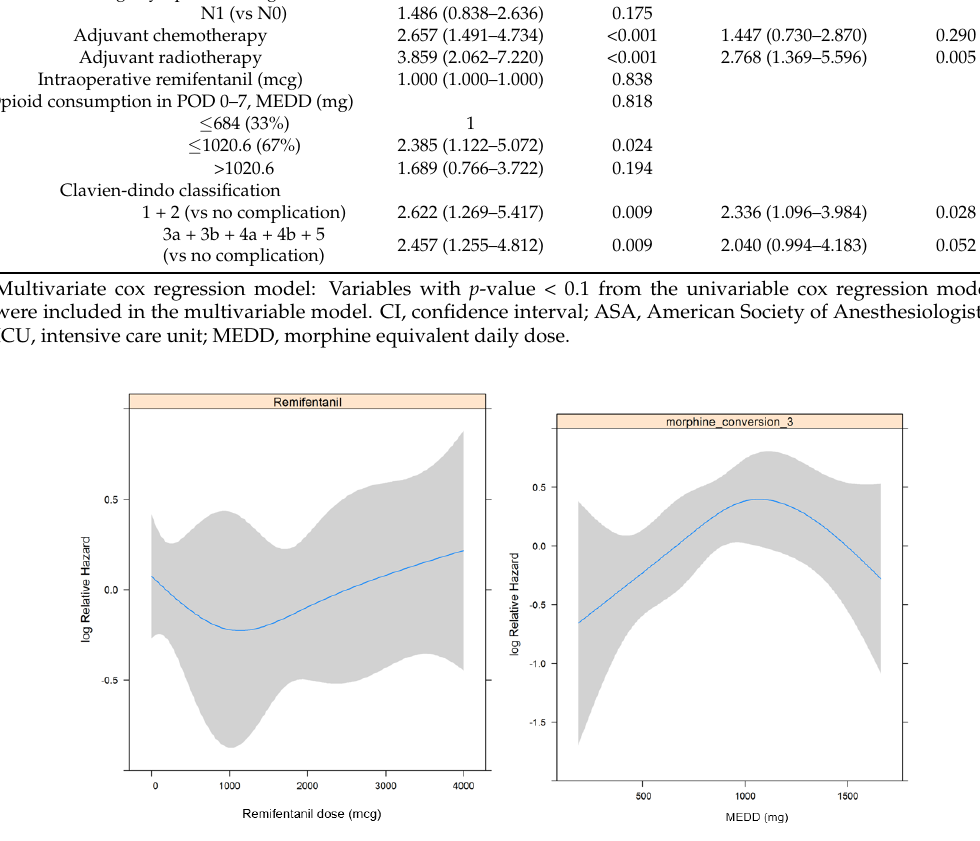
Figure 3. Restricted cubic spline in relation to opioid dosage (a) and remifentanil dosage (b) with recurrence-free survival.